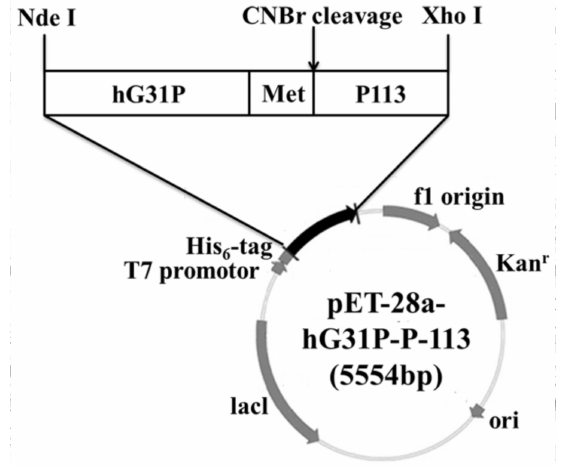
Figure 1. Gene map of the recombinant plasmid